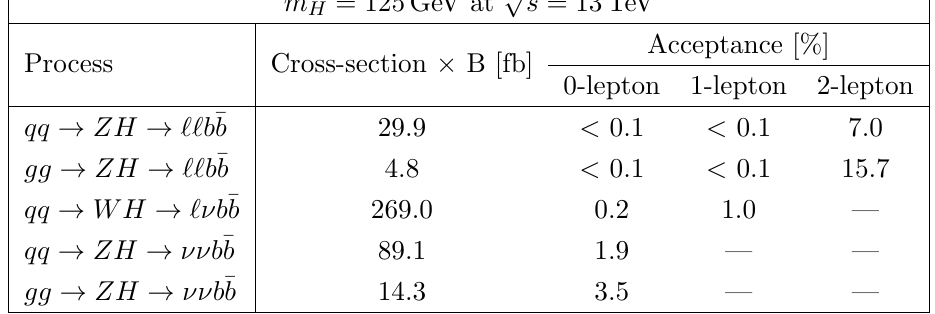
Table 3 . The cross-section times branching ratio (B) and acceptance for the three channels at p s = 13 TeV. The qq - and gg -initiated ZH processes are shown separately. The branching ratios are calculated considering only decays to muons and electrons for Z ! ‘‘ , decays to all three lepton (cid:13)avours for W ! ‘(cid:23) and decays to all neutrino (cid:13)avours for Z ! (cid:23)(cid:23) . The acceptance is calculated as the fraction of events remaining in the combined signal and control regions after the full event